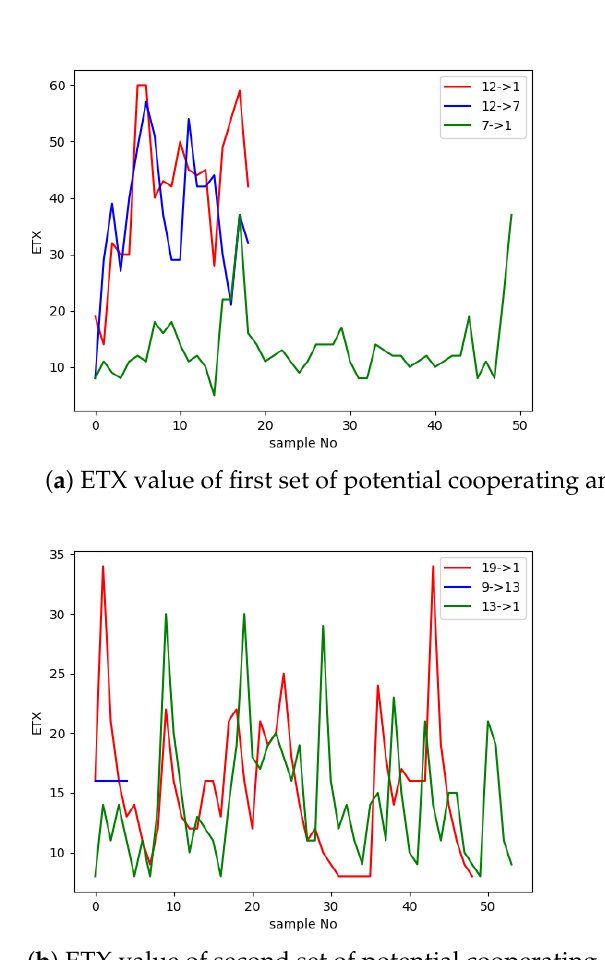
Figure 7. ETX values of two sets of nodes. Subfigure ( a ) shoss trhe ETX value of the first set of cooperative and direct links while subfigure ( b ) the value of the second set of cooperative and direct